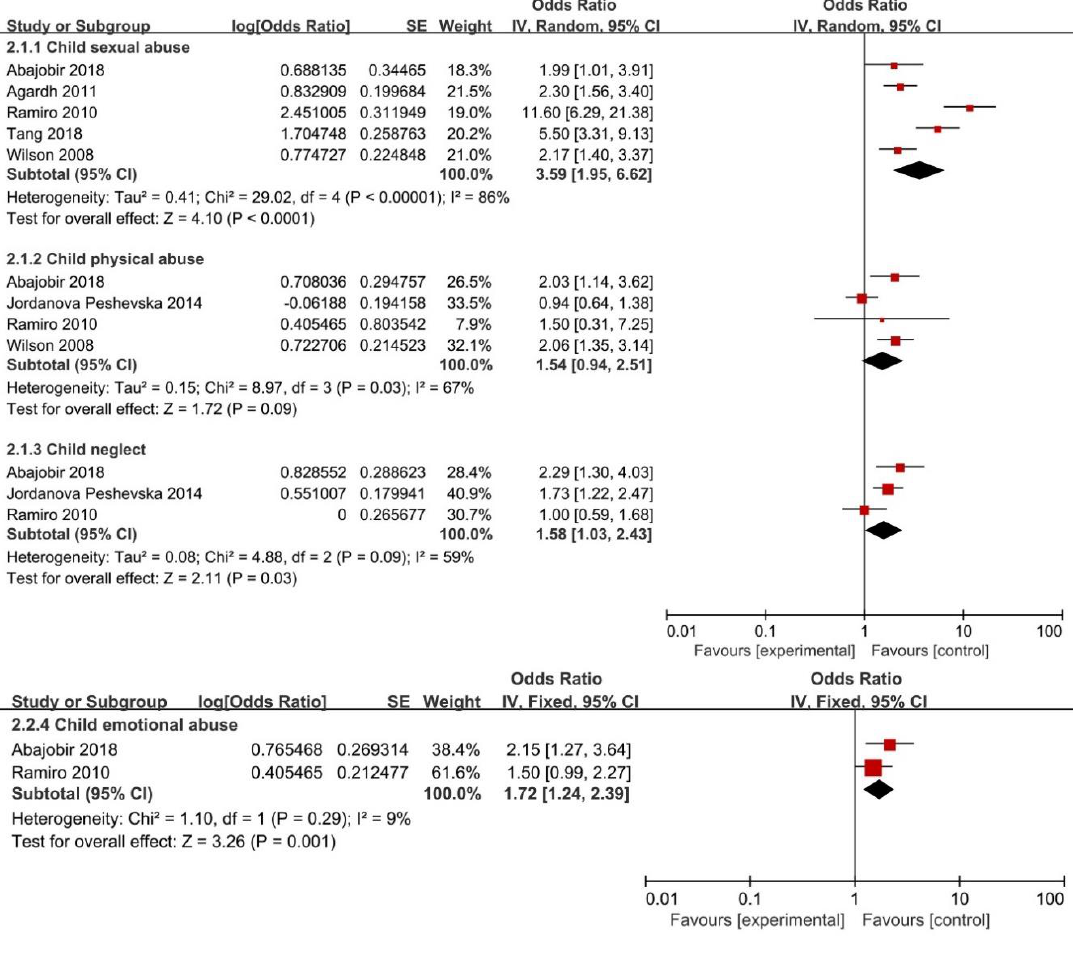
Figure 3. Forest plot for subtypes of childhood maltreatment and risk of having an early sexual